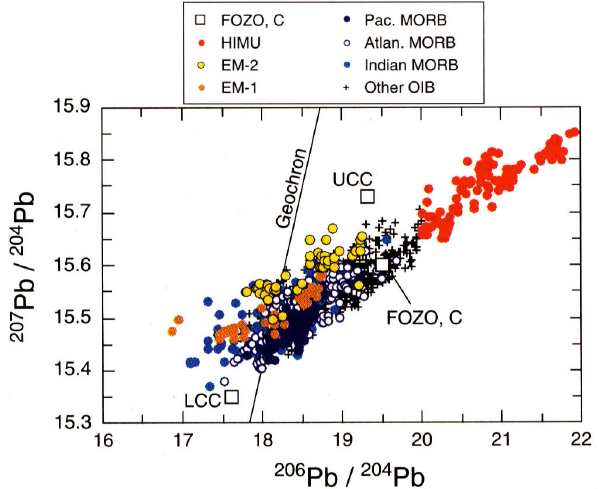
Fig. 2. Observed lead isotopic heterogeneity of mantle-derived rocks. FOZO, C: putative mean compositions; HIMU, EM-1, EM- 2: classes of OIBs; UCC: upper continental crust; LCC: lower con- tinental crust; Geochron: locus of meteorite values. From Hof- mann (1997). Reprinted from Nature with permission. Copyright Macmillan Magazines Ltd.